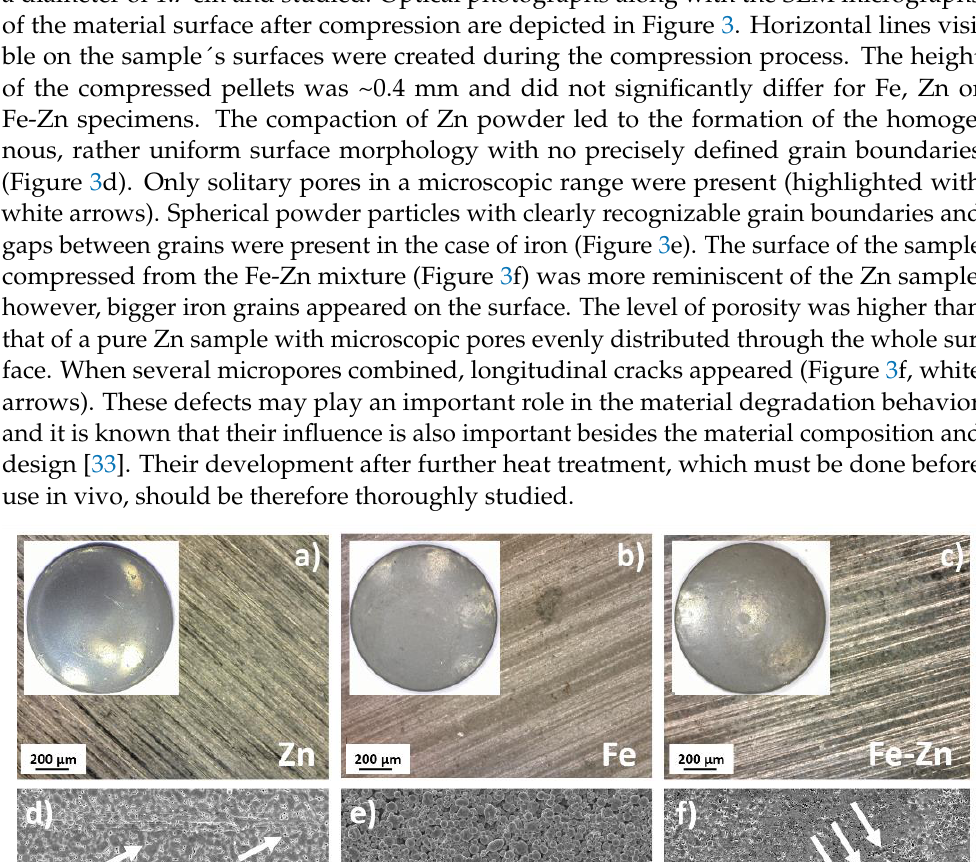
Figure 4. XRD spectrum of Zn, Fe and Fe-Zn compressed metallic powders. 3.2. Degradation Behavior of Compressed Fe, Zn and Fe-Zn Powders Degradation in Hanks´ solution simulating body fluids were studied electrochemi- cally. Open circuit potential (OCP) was stabilized over 1 h to reach the equilibrium state before further corrosion measurement (Figure 5a). Each sample reached a stable state even before one hour. Zn and Fe-Zn samples were stabilized after ~500 s while the sample made of pure iron after ~1000 s. The most positive potential was observed for the Fe sample starting around − 0.300 V which subsequently decreased to the lower value ( − 0.564 V). The starting potential of both Zn and Fe-Zn samples was under − 1.0 V. While in the case of pure zinc this value slightly increased in the initial period, in the case of Fe-Zn, it was the other way around. After one hour, the most negative values of potential were observed for Zn, followed by the Fe-Zn and Fe, respectively.